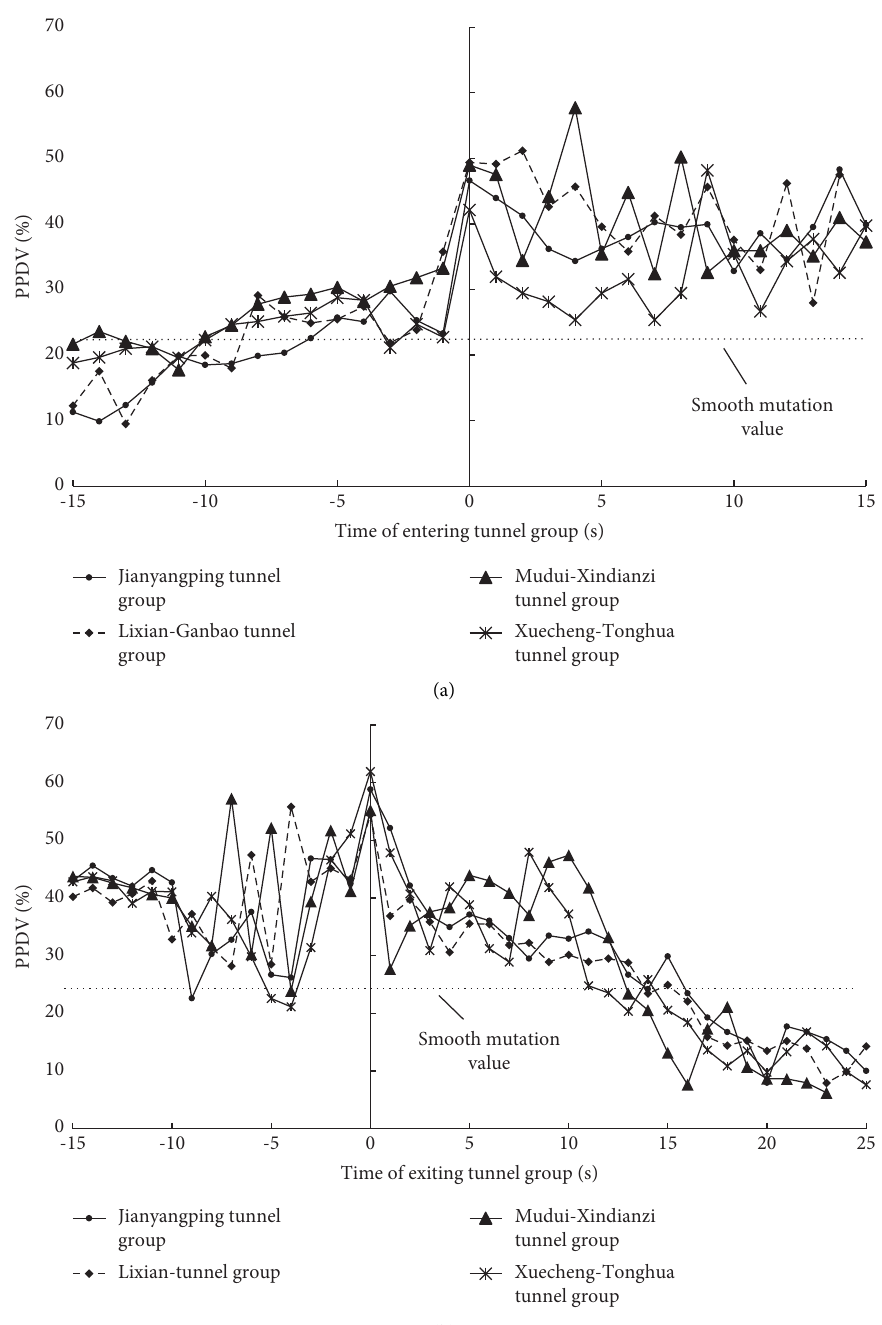
Figure 8: Analysis of influence range of tunnel groups. (a) Entrances of different tunnel groups. (b) Exits of different tunnel (3) Fifteen seconds (Jianyangping Tunnel group: 13 seconds; Lixian tunnel group: 15 seconds; Mudui tunnel group: 14 seconds; Xuecheng tunnel group: